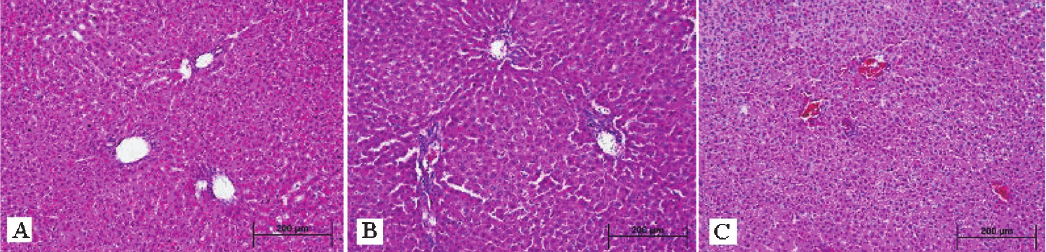
Figure 1 - (A) In group 1, normal liver tissue was observed on histopathological examination (hematoxylin–eosin, original magnification 6 200); (B) in group 2, hepatocyte necrosis and congestion of the sinusoids and central vein on liver tissue were seen (hematoxylin– eosin, original magnification 6 200); (C) in group 3, minimal central vein congestion in hepatic lobules and significantly less tissue damage on hepatocytes were seen (hematoxylin–eosin, original magnification 6